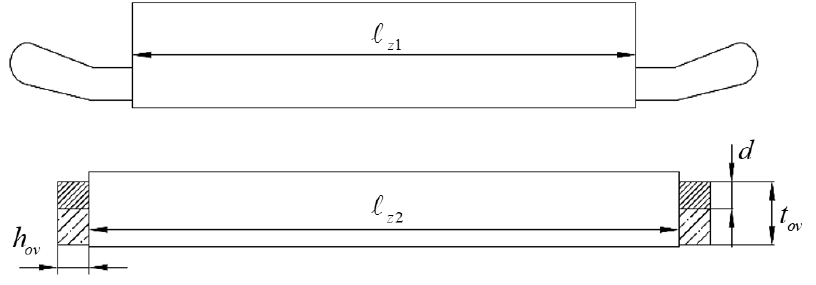
Figure 7. Section view of linear motor with slotted